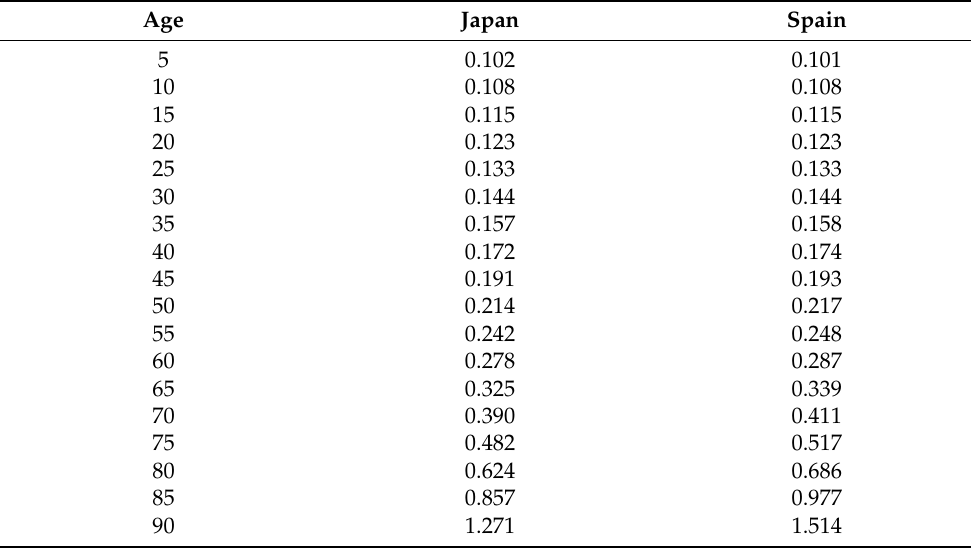
Table 2. Keyfitz entropy measurement [15] for the female population for each specific age.